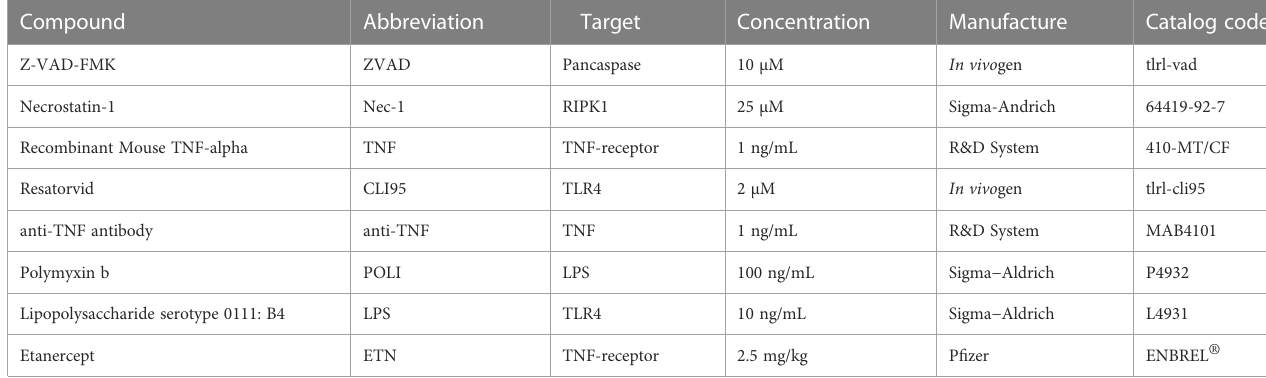
TABLE 1 List of small molecules and biodrugs used as pharmacological inhibitors.